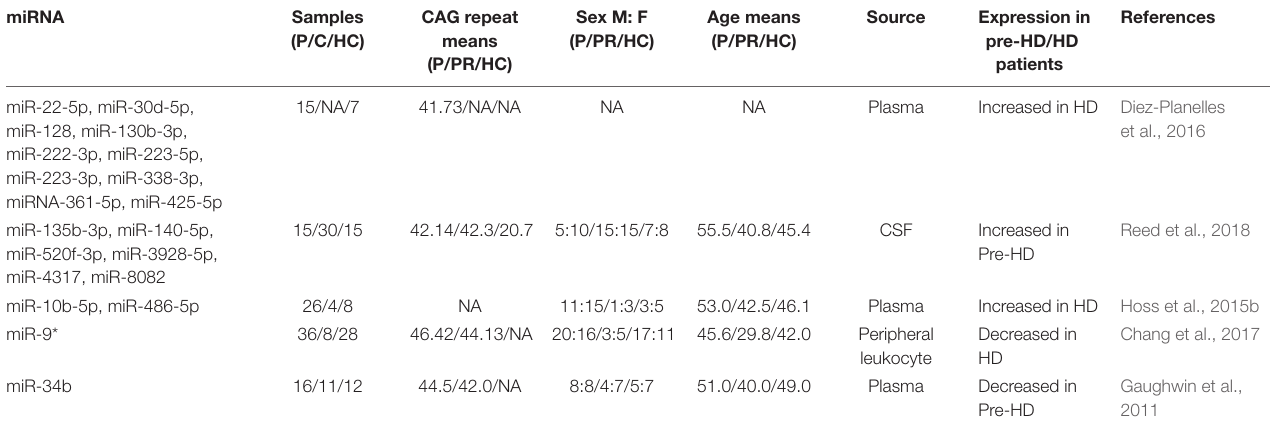
TABLE 2 | Circulating miRNAs as biomarkers in HD. miRNA Samples